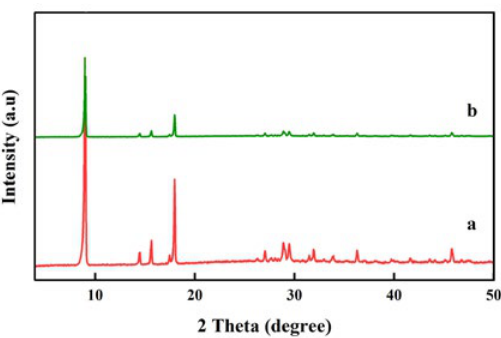
Fig. 4. PXRD pattern resulting from calcination of the [Cu(BDC) ) MOF at 500 ° (bipy)](BDCH 2